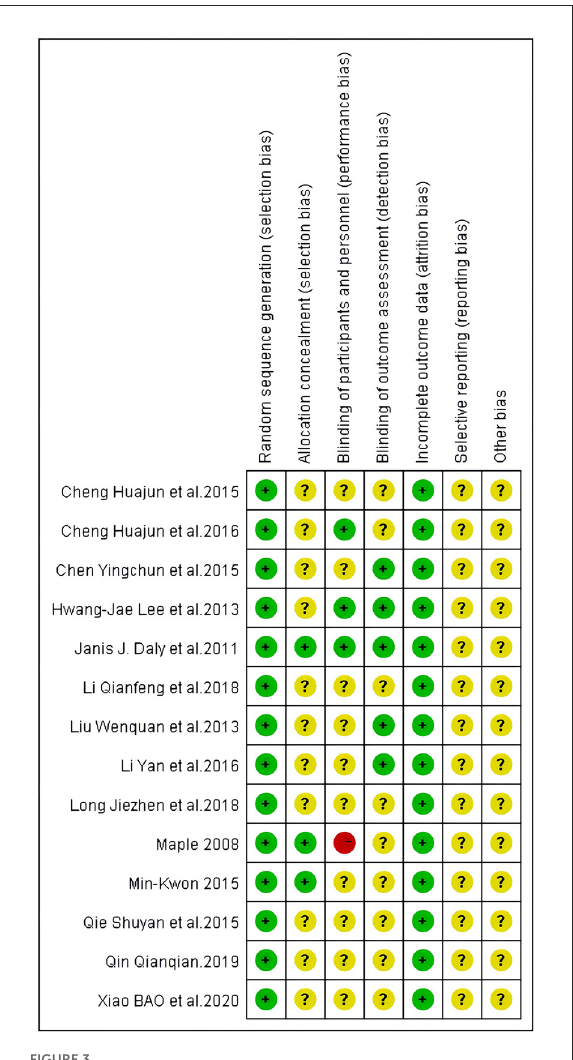
FIGURE3 Risk of bias summary: judgements about each risk of bias item for each included